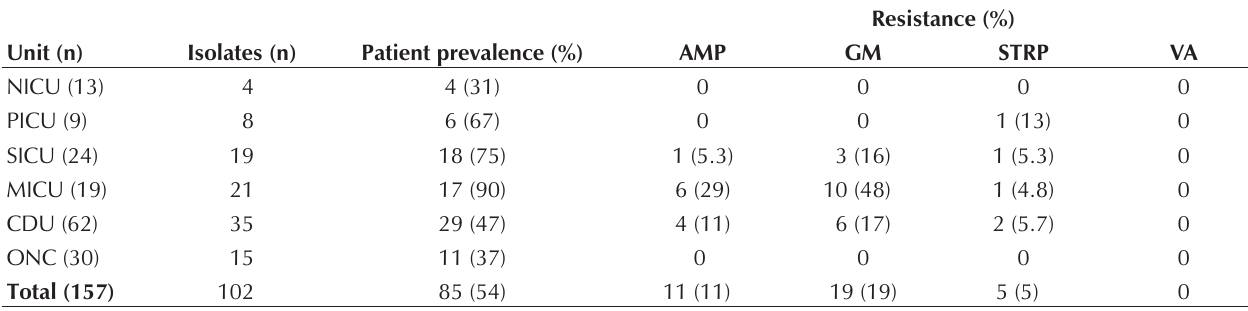
Antimicrobial resistance profiles of Enterococcus species isolated